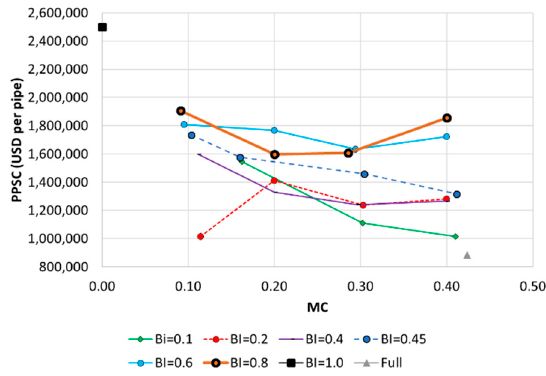
Figure 6. Per pipe system cost (PPSC) and MC values of the 25 networks grouped by BI values.